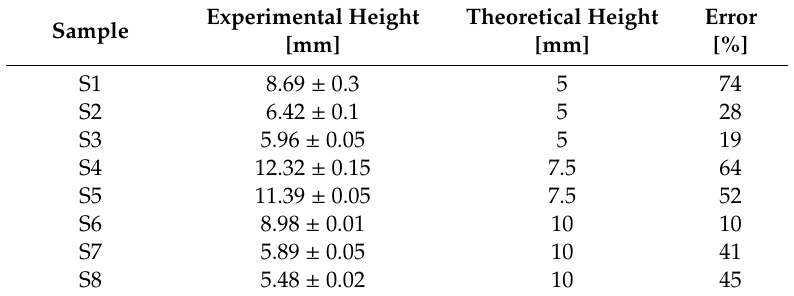
Table 4. Experimental height variation as compared to the theoretical value in case of LMD deposited samples.